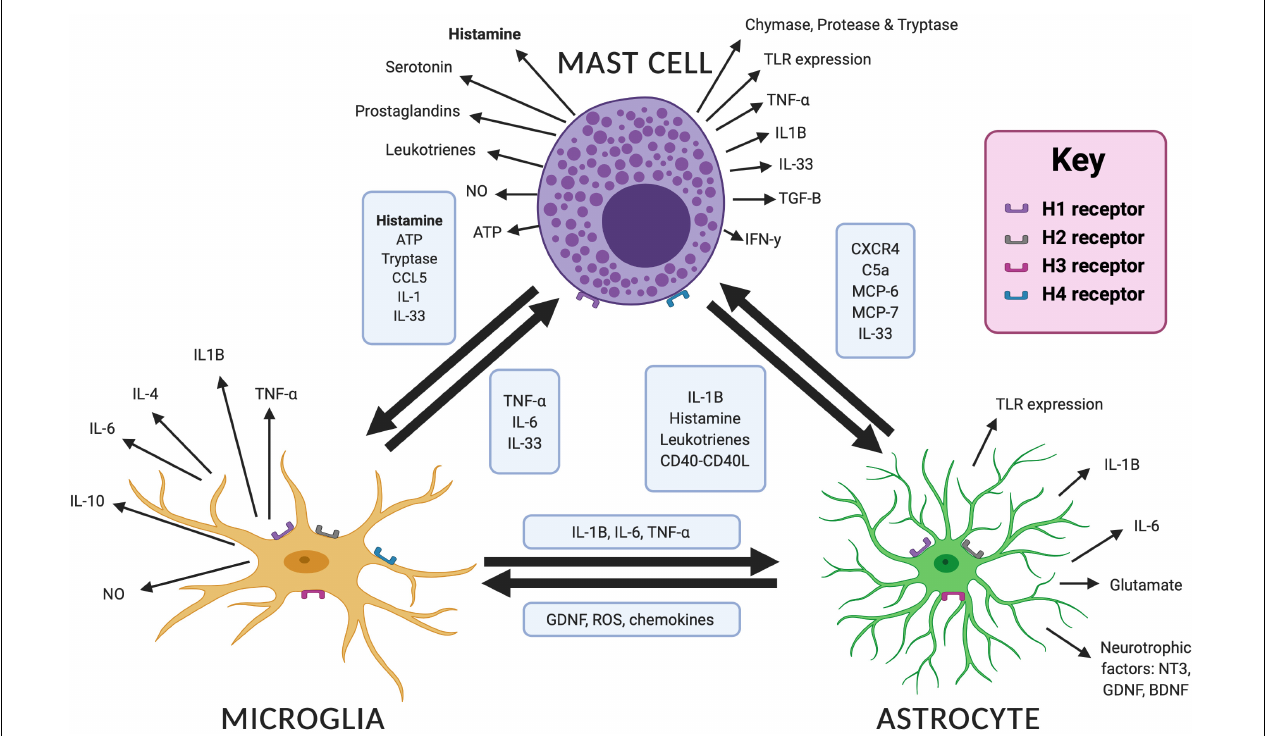
FIGURE 2 | Interactions and mediators between mast cells, microglia and astrocytes in the brain. Bidirectional interactions are demonstrated between each cell type with the mediators involved in boxes. Different mediators are released in response to cellular activation, which are shown for each cell type. Image created with BioRender.com. ATP, adenosine triphosphate; BDNF, brain derived neurotrophic factor; CCL5, C–C motif chemokine ligand 5; C5a, complement 5a; CXCR4, CXC chemokine receptor 4; GDNF, glial derived neurotrophic factor; IL, interleukin; MCP, mast cell protease; NO, nitric oxide; NT3, neurotensin 3; ROS, reactive oxygen species; TLR, toll like receptor; TNF- α , tumor necrosis factor